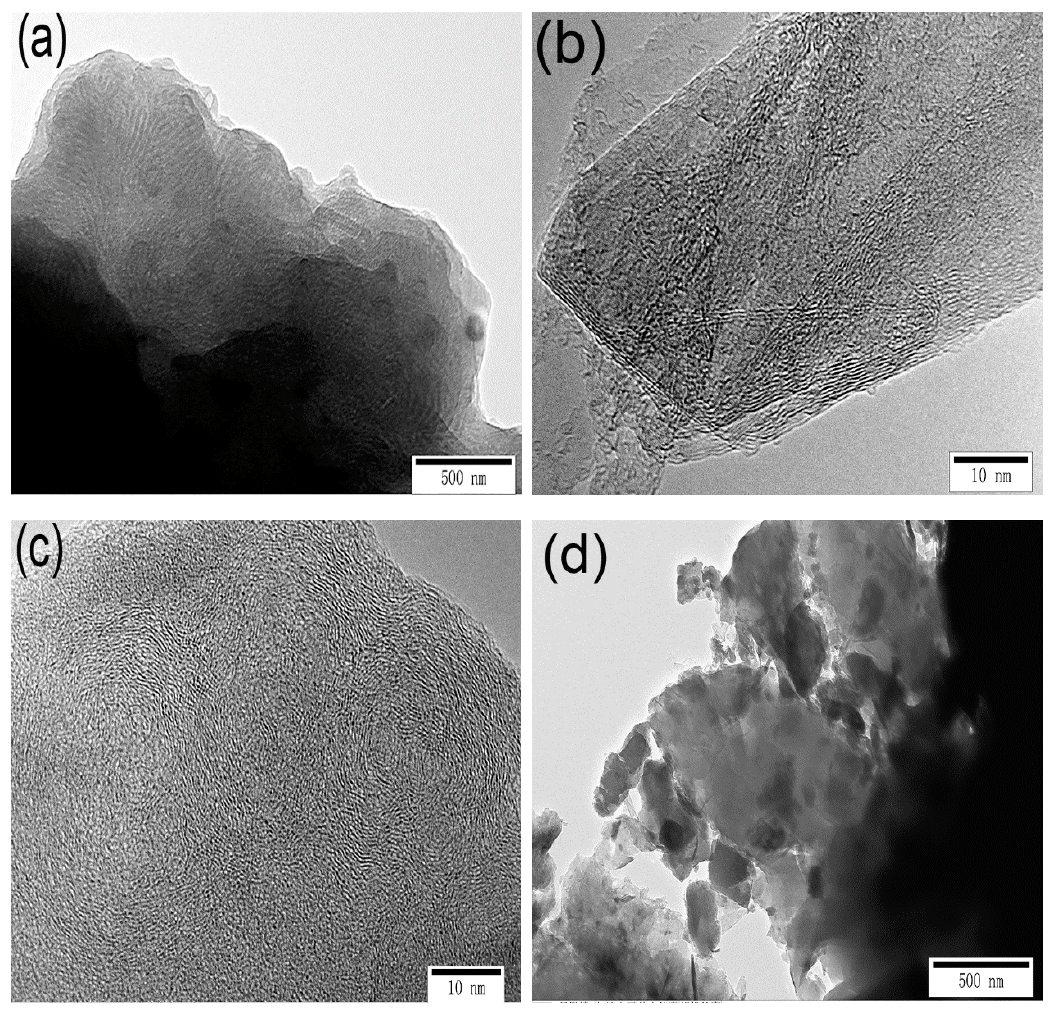
Figure 4. Microstructures of the carbon cathode at testing time 120 min with a cathode current density of 0.7 A/cm 2 (a) and (d) TEM image (b) and (c) HRTEM image.